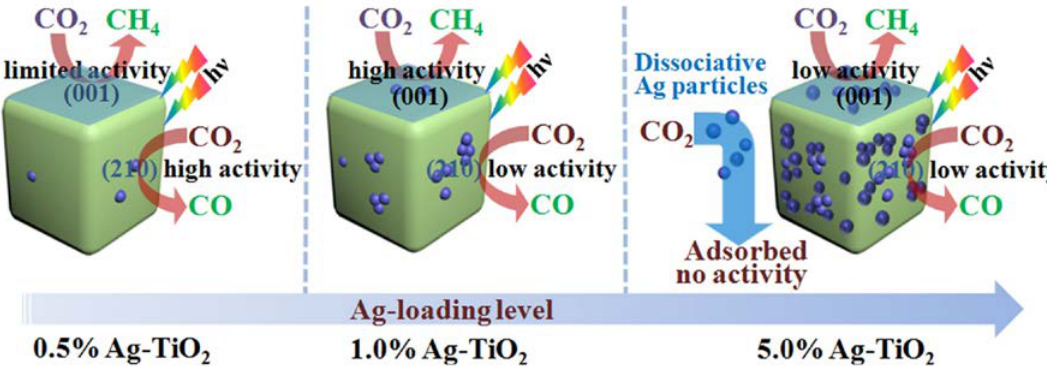
Figure 6. Graphical representation of the influence of Ag co-catalyst wt. % content on the CO 2 photoreduction activity of brookite nanocubes. Reproduced from reference [94] with permission of Elsevier, 2017.